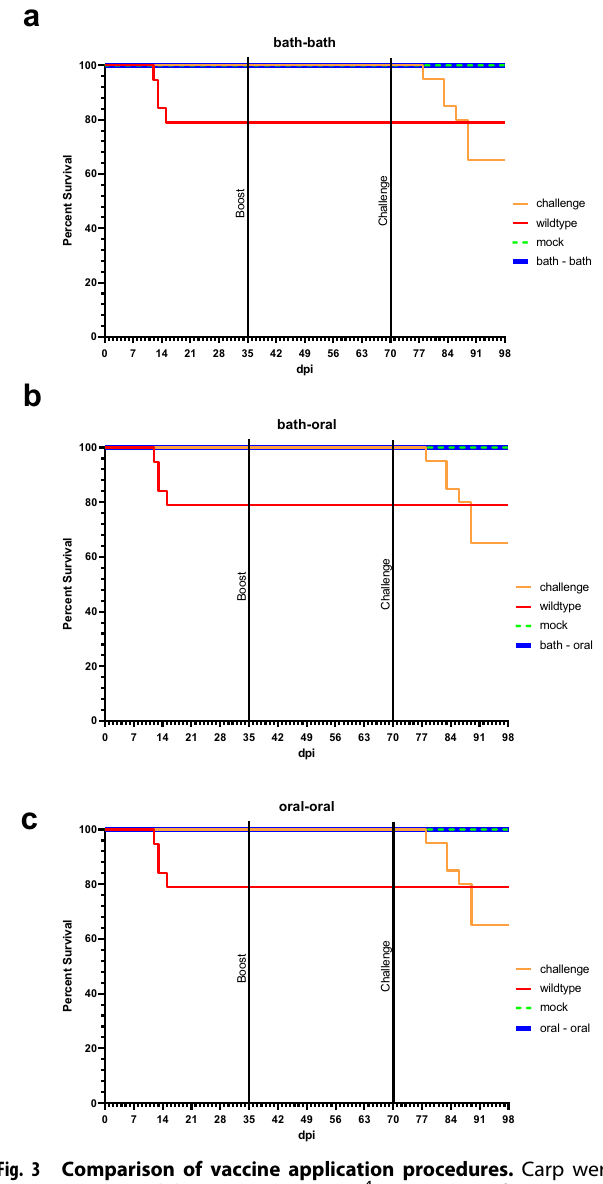
Fig. 3 Comparison of vaccine application procedures. Carp were prime immunized by immersion in 10 4 TCID 50 /mL of KHV-T P78 a , b or by feeding for 3 days with a total of 10 9 TCID 50 of KHV-T P78 encapsulated in alginate c . Five weeks later boost immunization was done with the same procedure, by immersion a and orally b, c . Challenge infection was performed by immersion in 10 5 TCID 50 /mL with wild type KHV-T at 70 dpi. Immunized fi sh (blue line) survived challenge infection without any documented